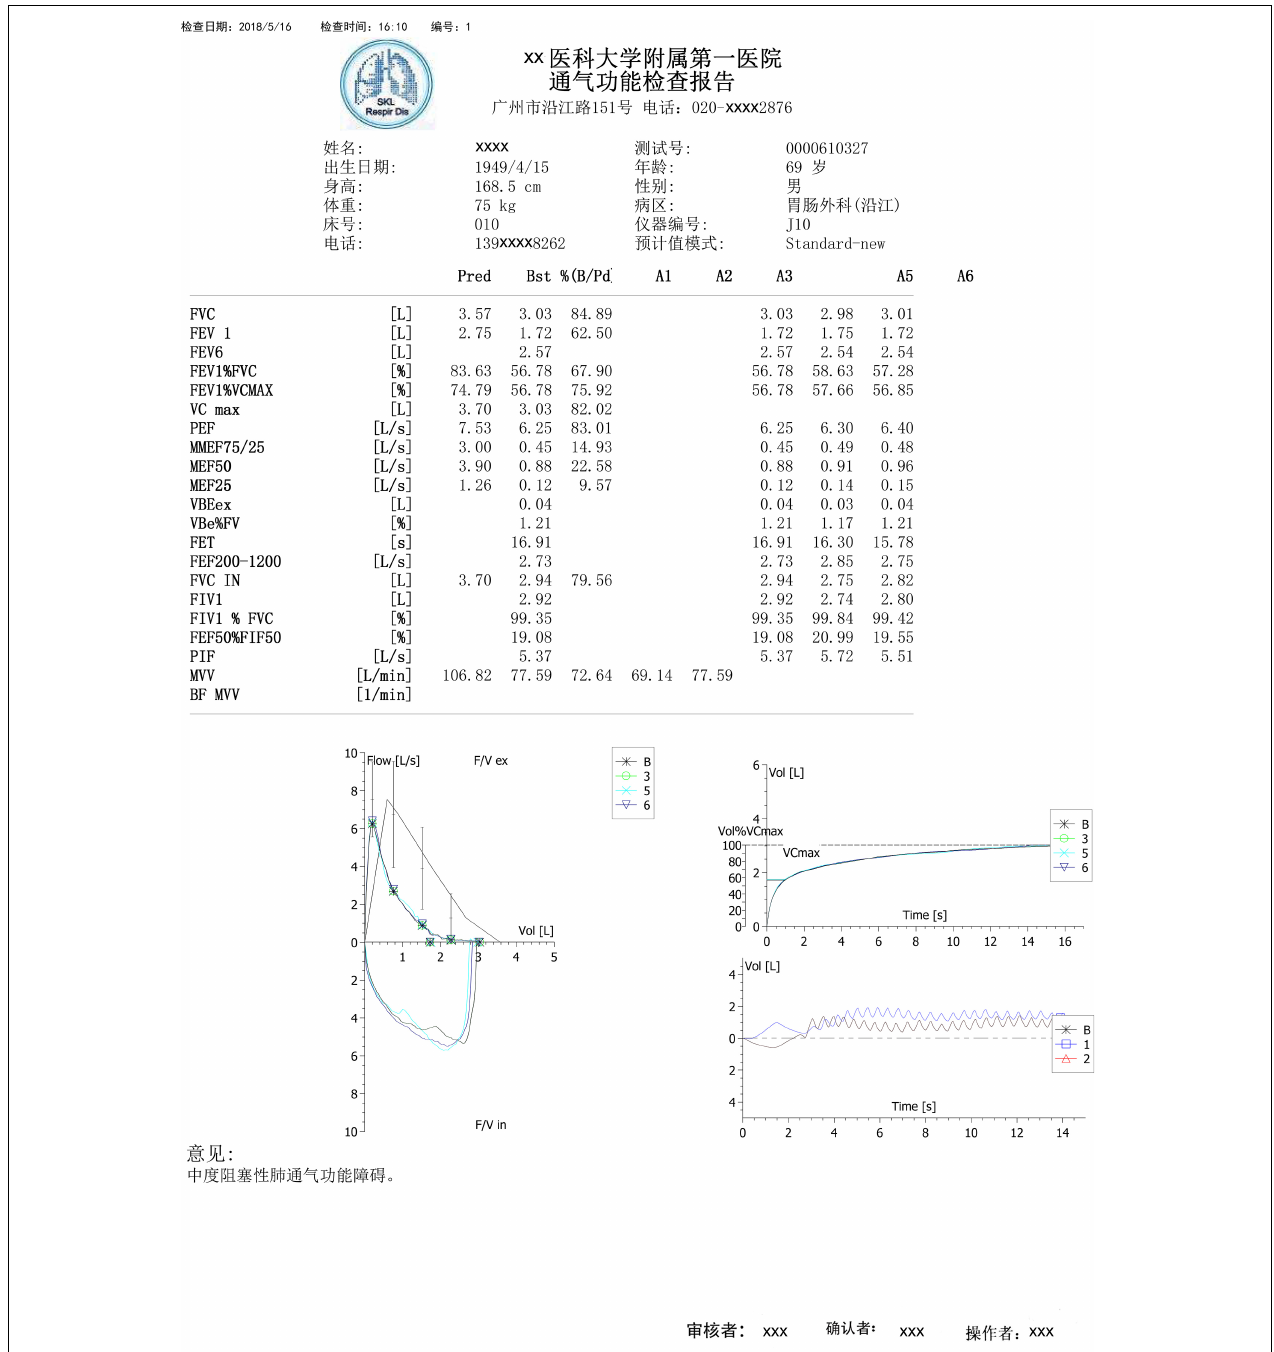
FIGURE 1 | A typical example of a spirometry record. A typical spirometry record in a pdf includes parameters, flow–volume curves, and volume-time curves, which were obtained from devices. Example in the Chinese language.